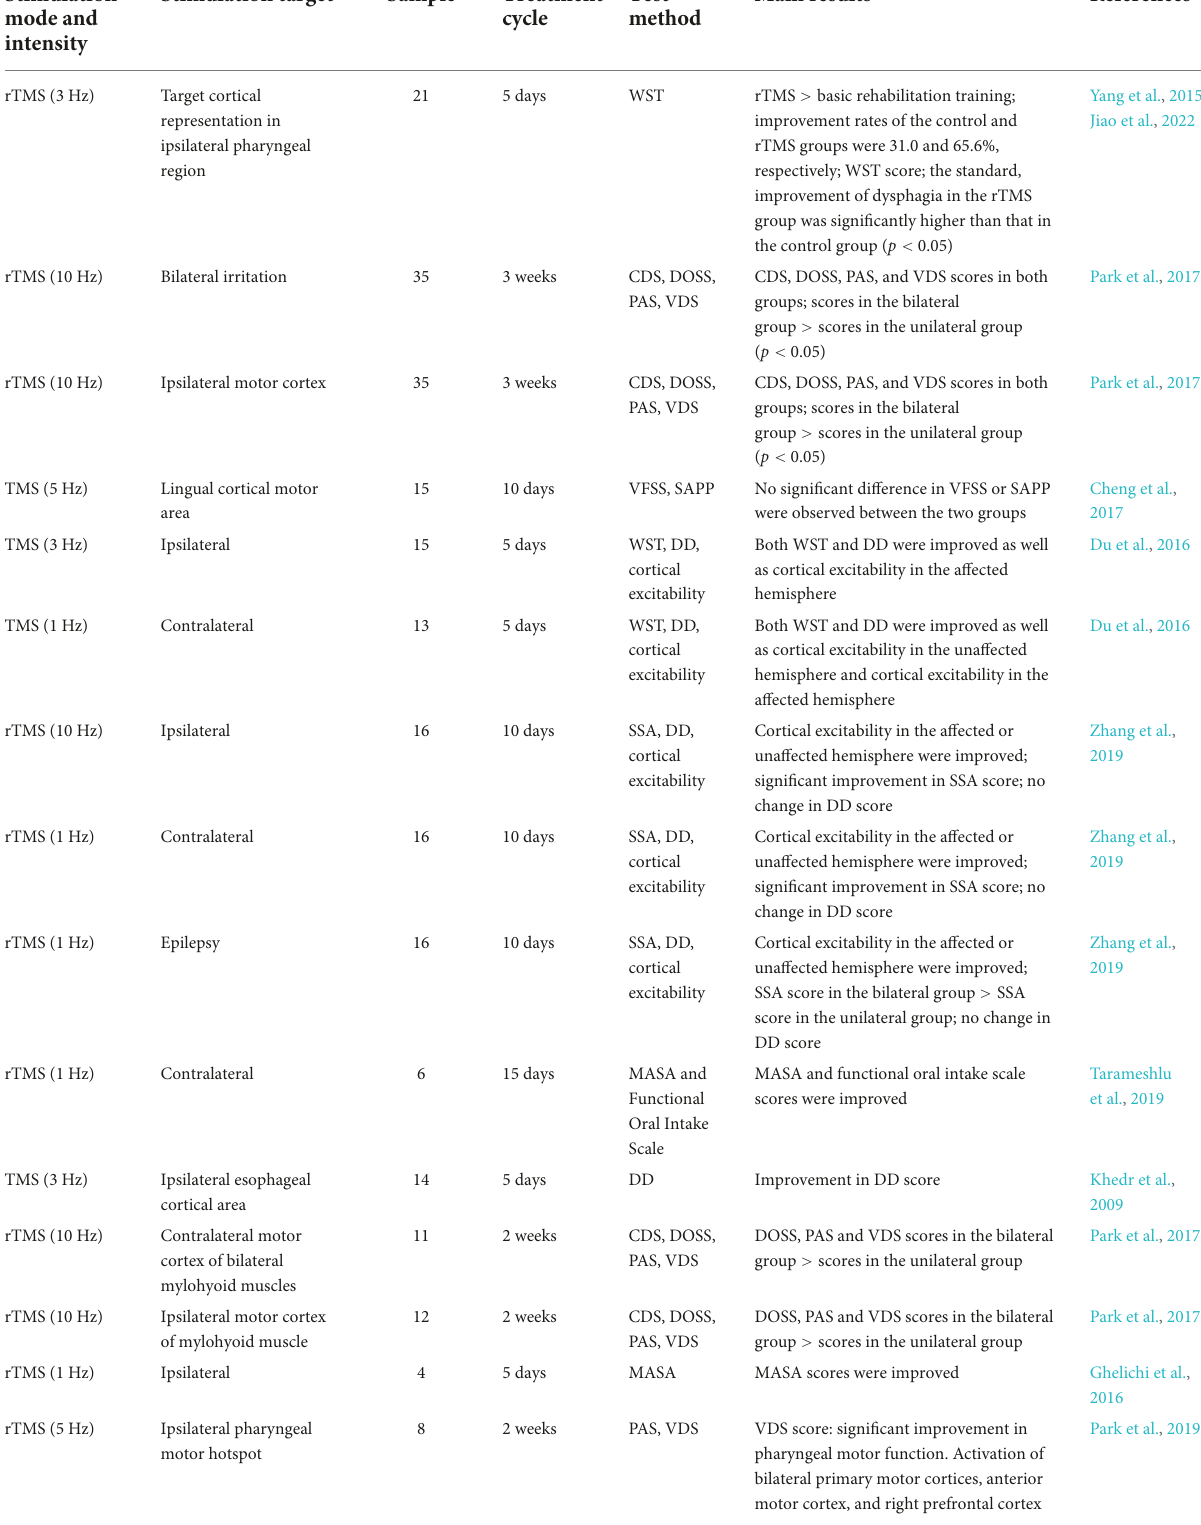
TABLE 1 Summary of studies on the efficacy of TMS for PSD from clinical trials and meta-analyses.